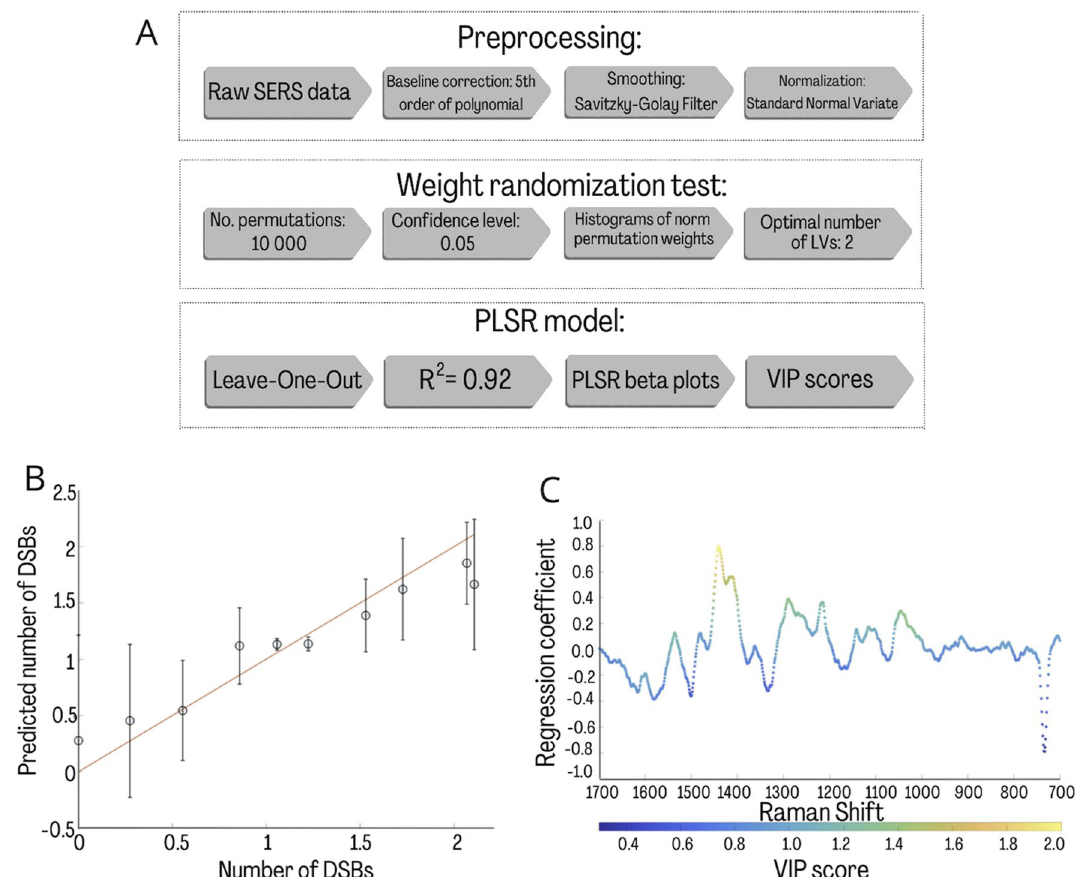
Figure 5. ( A ) A schematic representation of the analysis performed on the raw SERS spectra to build the PLSR model. The obtained values for each analysis step are presented. PLSR model for the number of DSBs. ( B , C ) Predicted versus observed values calculated based on AFM images according to the formula described in the “Materials and methods” section 50 ( B ) and regression coefficient (β) plot ( C ). Averaged spectra of the corresponding parameter were used as the PLSR model